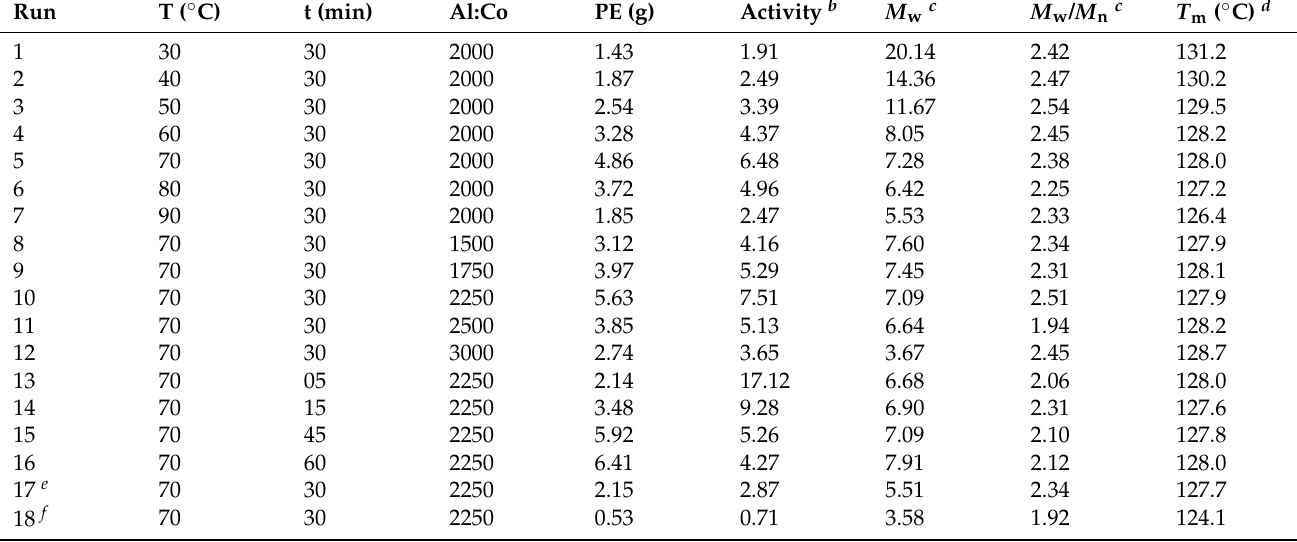
Table 3. Optimization of the polymerization conditions using Co1 /MMAO a